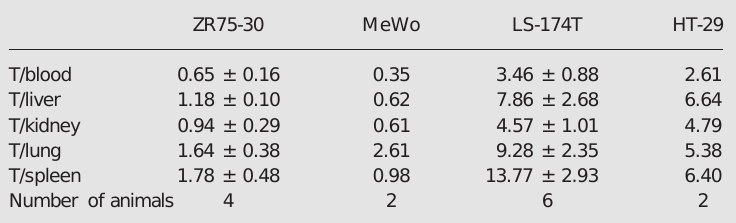
Table 1 – Tumor (T)-to-normal-tissue ratios in mouse tissues obtained 24 h after 99m Tc- 6D1.1 mAb injection. Tumor-to-normal tissue ratios were obtained by dividing the concentration of radioac- tivity in tumors by those of each normal tissue indicated. LS-174T and HT-29 are CEA- producing cells while ZR75-30 and MeWo are not. Results for the two groups composed of more than two animals are presented as means ±